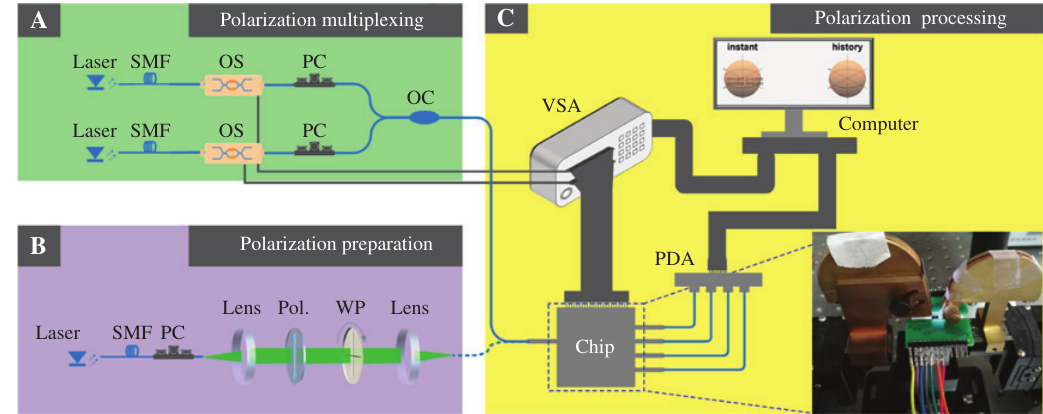
Figure 2: Experimental